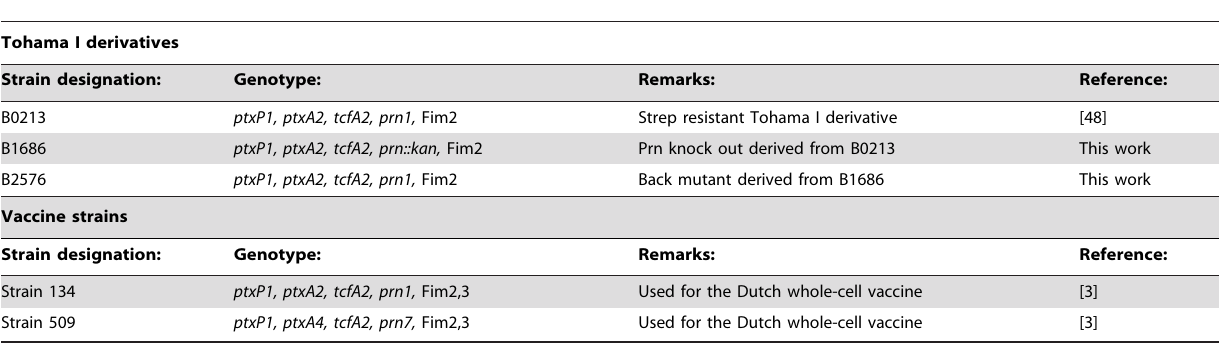
Table 1. Characteristics of strains used in this study 1